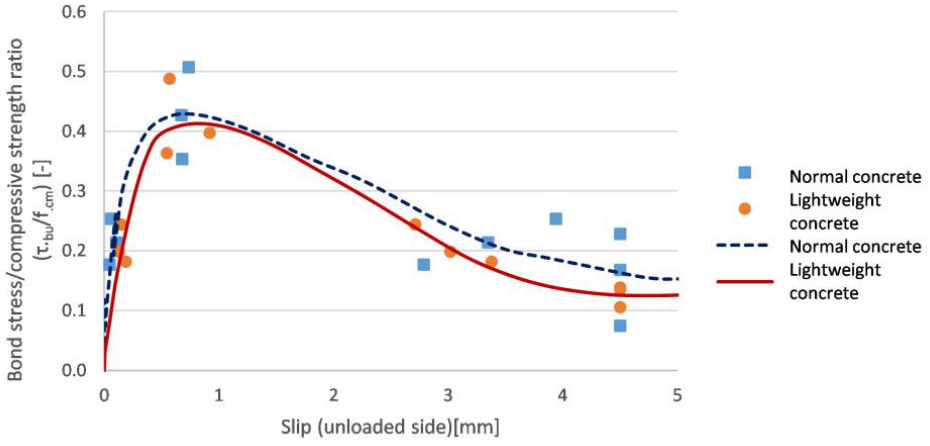
Figure 16. Bond strength ratio of normal- and lightweight concrete (discrete values) and their aver- age